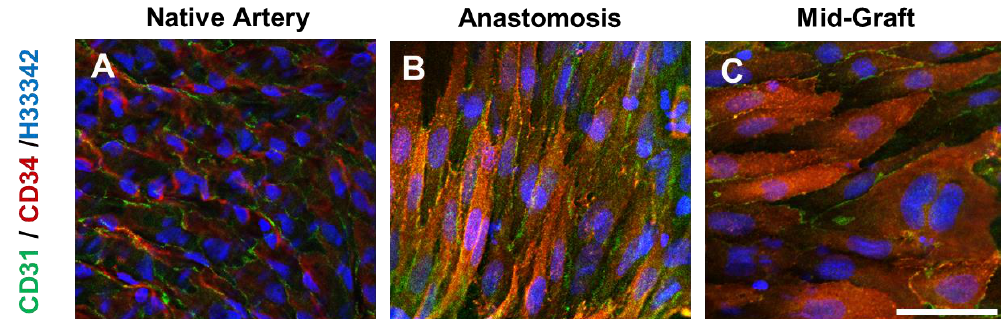
Figure 10. En face immunostaining for CD 31 ( green ) and CD34 ( red ) of the ( A ) native artery, and heparinized vascular grafts at 2 weeks after implantation at the ( B ) anastomotic and ( C ) mid-graft sites. Scale bar = 50 μm.